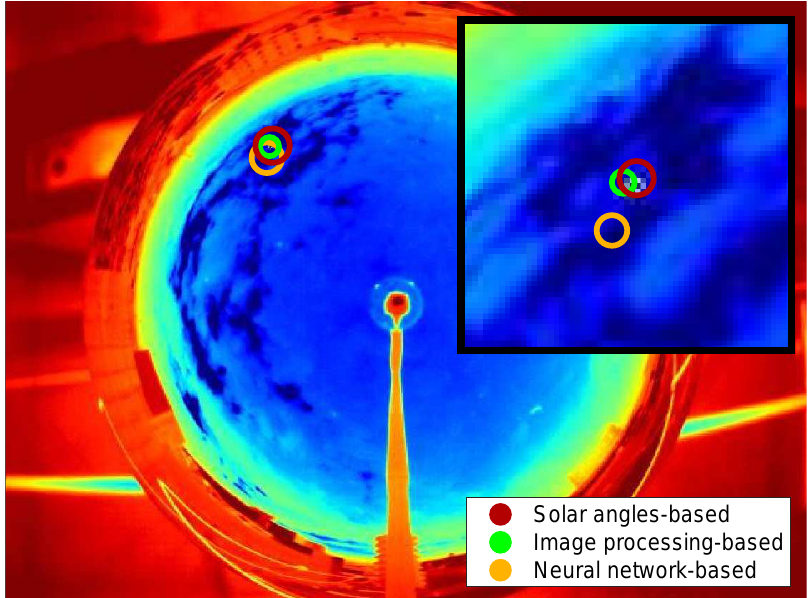
Figure 16. Representation of the structure of the designed Artificial Neural Network